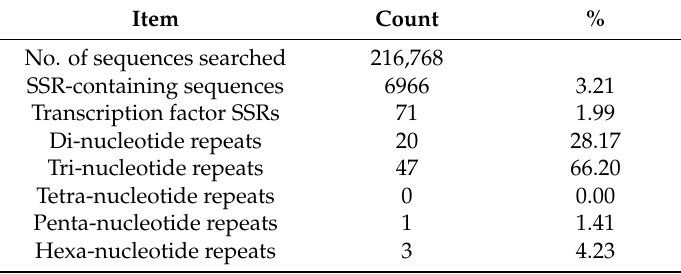
Table 1. In silico characterization of transcription factor simple sequence repeats (SSR) (TFSSR) extracted from transcription factor (TF) sequences of lily for marker